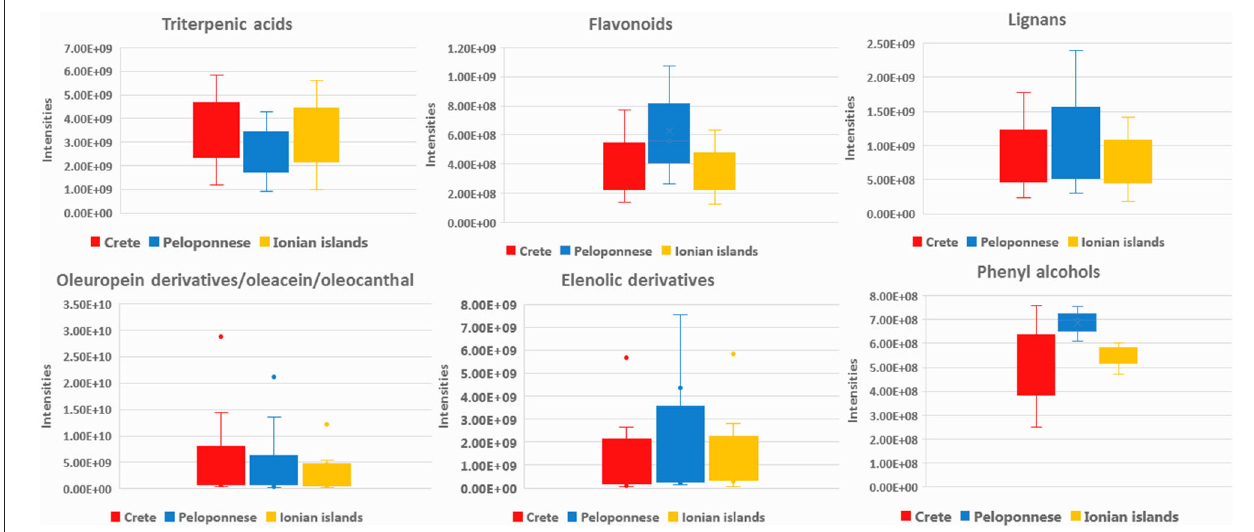
FIGURE 5 | Box-plots representing intensities of statistical significant compounds grouped according to their chemical class; triterpenic acids, flavonoids, lignans, secoiridoids (oleuropein derivatives, oleacein, and oleocanthal), and elenolic acid derivatives as well as phenyl alcohols. Box-plots are presented according to geographical origin: Crete (red), Peloponnese (blue), and Ionian islands